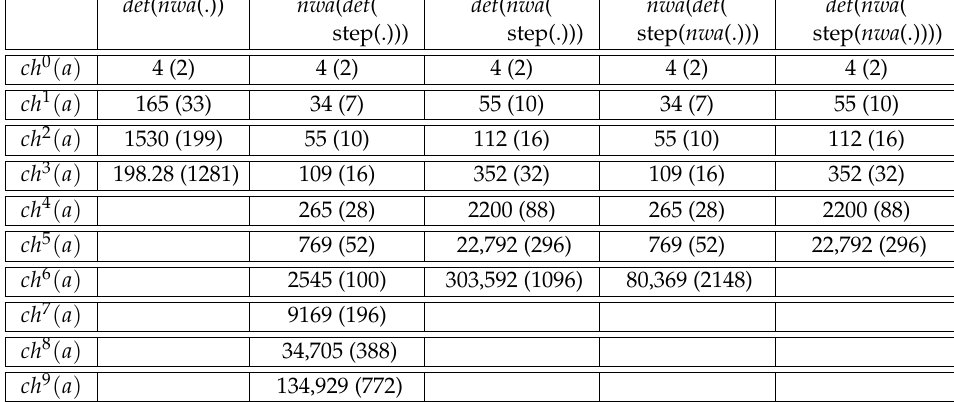
Figure 27. Deterministic NWAs for the queries ch n ( a ) where n = 0, . . . ,9: size (#states). There is no schema-based cleaning. Our implementation of the minimization algorithm was applied to all dSHA with at most 200 states, since it failed for larger dSHA s. No minimization algorithm for subclasses of single-entry dNWAs was implemented.